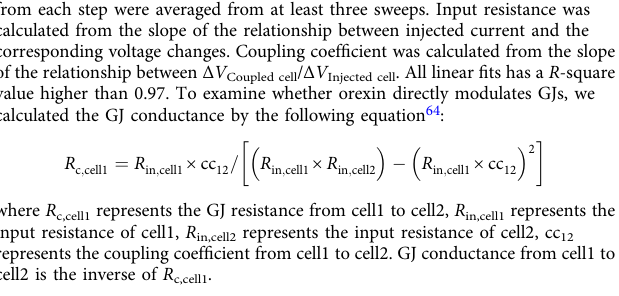
(Carl Zeiss, Germany) and analyzed by Zen software 2012 (Carl Zeiss, Germany). Histological processes were also performed to locate the sites of CTB/virus injec- tions and drug canula/electrode/optical fi ber implantations. Data were excluded if the locations were not correct. Cell counting . To quantify the SLD-projecting or LC-projecting orexin neurons, six coronal sections of each CTB-injected rat containing the LH with a distance of 200 µm (between AP: − 2.30 and − 3.80 mm) were collected. After orexin-A immunostaining, we counted the number of total orexin neurons, CTB-488-labeled ratio of each group was then reported. To examine the REM sleep-related activities of OX SLD neurons, c-Fos immunostaining was further applied in rats with CTB- 488 injection after recovery from RSD and the control rats. The counting method was